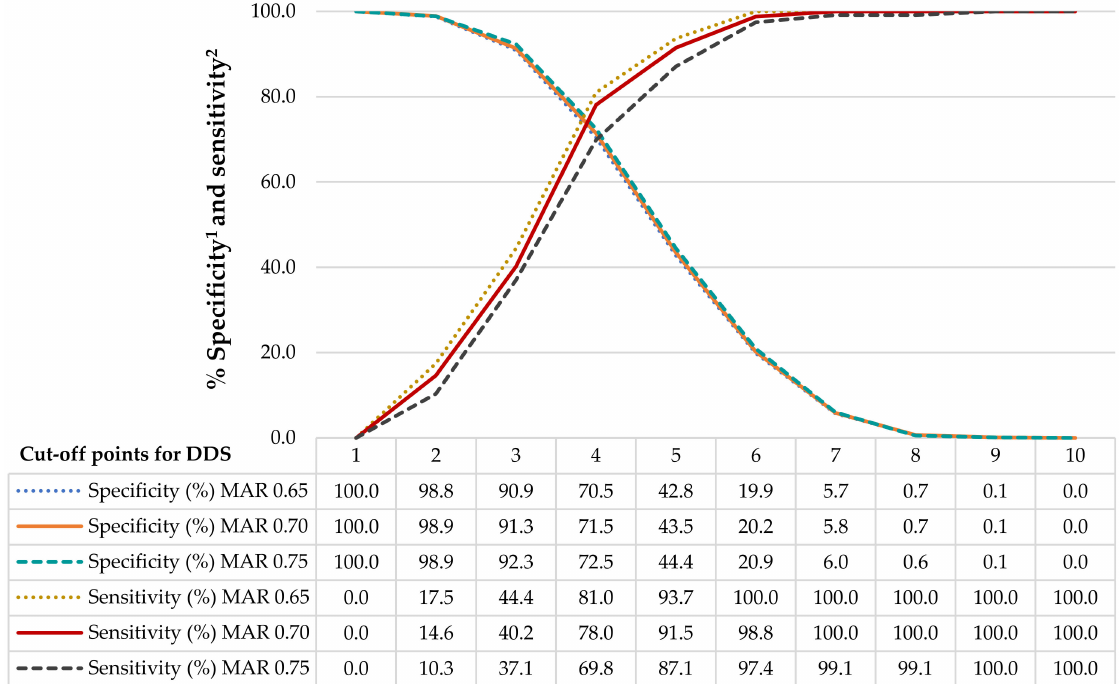
Figure 1. Sensitivity and specificity of different DDS cut-off points with MAR cut-off points ranging from 0.65 to 0.75. 1 Specificity: identifies nutritionally appropriate diets as adequate. 2 Sensitivity: identifies nutritionally inappropriate diets as inadequate. DDS: Diet Diversity Score; MAR: Mean Adequacy